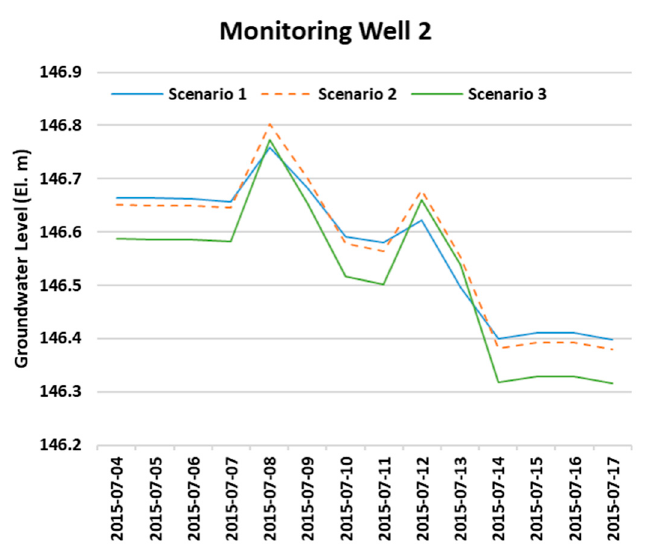
Figure 9. Inversion of simulated groundwater levels using the groundwater withdrawal scenarios for MW2.